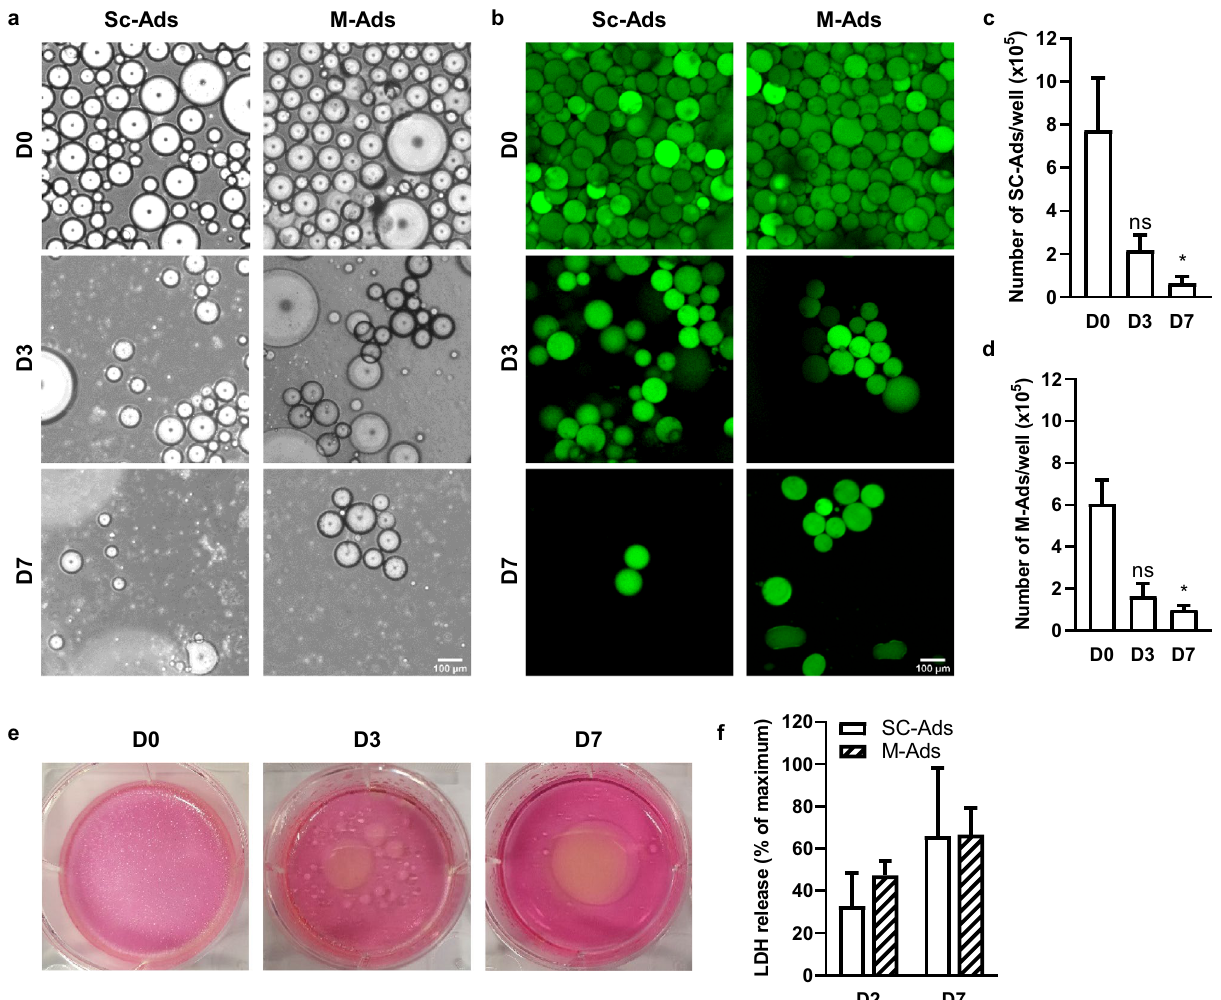
Figure 1. Like SC-Ads, M-Ads rapidly die when cultured in 2D. ( a ) Representative phase-contrast images taken under light microscope of human SC-Ads and M-Ads cultured in 2D for the indicated times; Scale bar, 100 µm. ( b ) Representative images of BODIPY® 493/503 (neutral lipids, green) stained primary SC-Ads and M-Ads in 2D culture for the indicated times; Scale bar, 100 µm. ( c , d ) Number of SC-Ads ( c ) and M-Ads ( d ) cultured in 2D over time (n = 3). ( e ) Representative pictures of the culture wells of M-Ads grown in 2D at indicated times points. ( f ) Quantification of LDH release in medium during 2D culture at D2 and D7 for SC-Ads and M-Ads (n = 3). The results are expressed as the percentage of the value obtained when the whole cell population (same cell number than D0) is lysed. The histograms represent mean ± SEM, ns non-significant, *P <